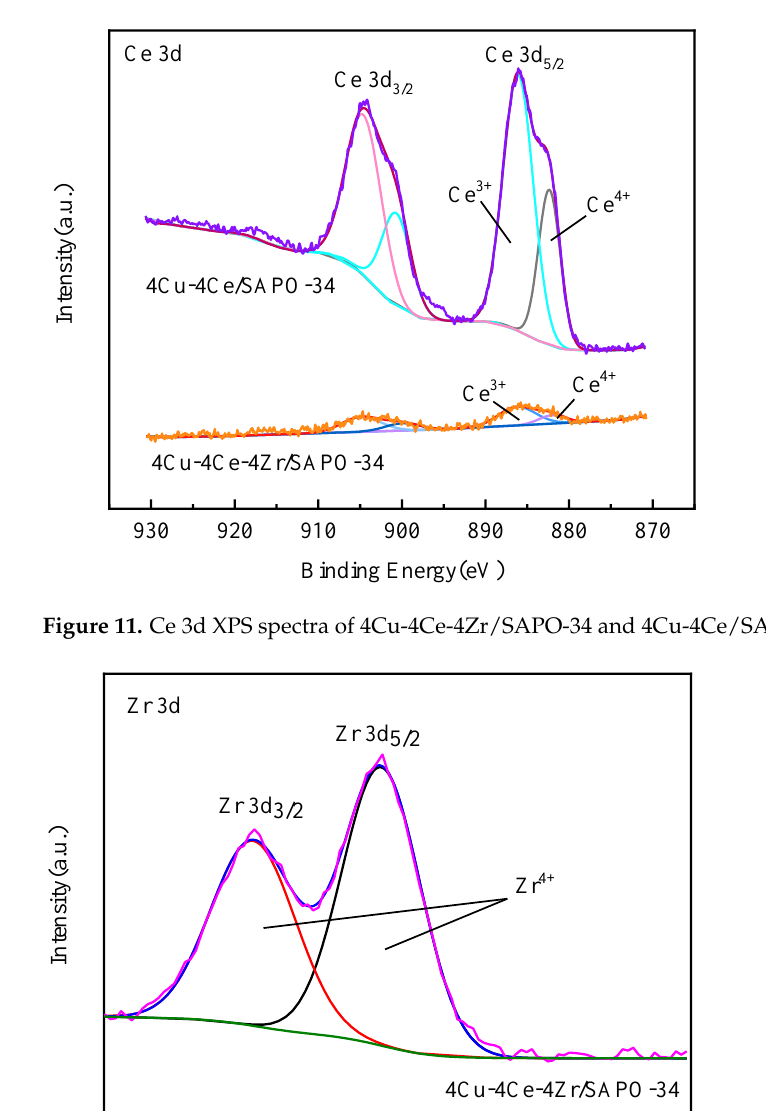
Figure 10. Cu 2p XPS spectra of 4Cu-4Ce/SAPO-34 and 4Cu-4Ce-4Zr/SAPO-34.